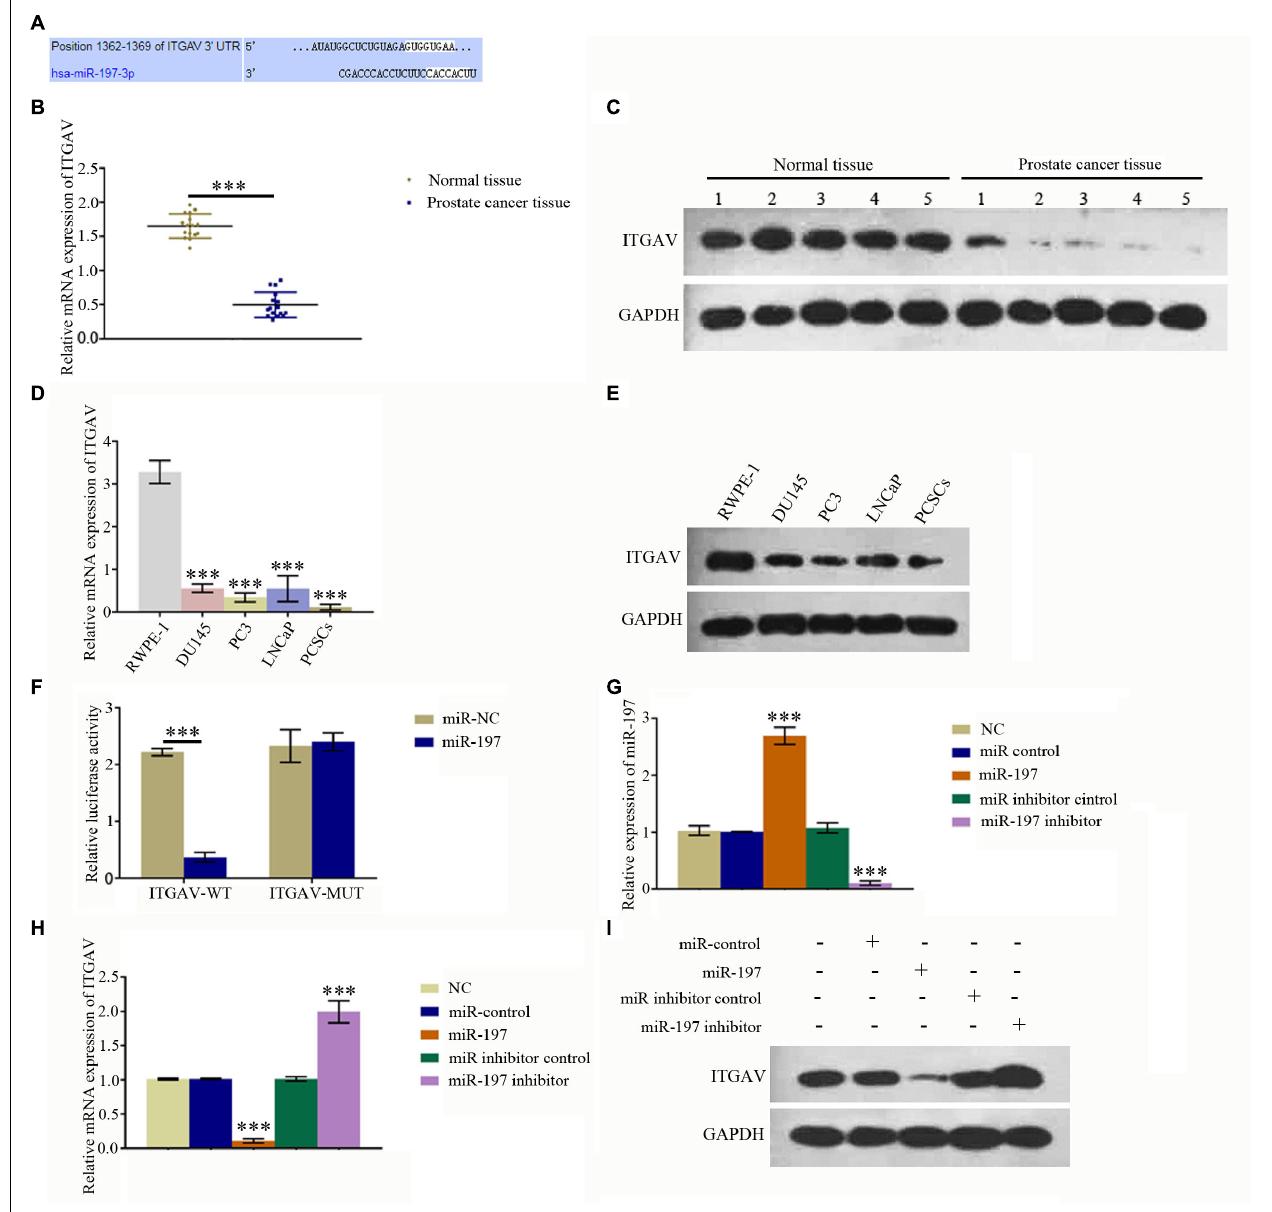
FIGURE 2 | MiR-197 regulated ITGAV expression in prostate cancer tissues and cells. (A) An online bioinformatics analysis was conducted using the TargetScan 7.2 database to determine whether ITGAV could be regulated by miR-197 and 1362–1369 of ITGAV 3 (cid:48) -UTR was found to target miR-197. (B) qRT-PCR assay showed the expression of ITGAV mRNA was lower in prostate cancer tissues. (C) Western blotting assay showed the expression of ITGAV protein was lower in prostate cancer tissues. (D) qRT-PCR assay found the expression of ITGAV mRNA was lowest in prostate cancer stem cells (PCSCs). (E) Western blotting assay determined the protein expression levels of ITGAV was lower in PC3 and PCSCs. (F) Dual luciferase reporter assay confirmed the direct interaction between miR-197 and ITGAV mRNA. (G) qRT-PCR assay determined the expression of miR-197 in PCSCs cells after transfection with the miR control, miR-197 mimic, miR inhibitor control and miR-197 inhibitor. The results showed the expression of miR-197 was lowest in miR-197 inhibitor group. (H) qRT-PCR assay determined the expression of ITGAV mRNA in PCSCs cells after transfection with the miR control, miR-197 mimic, miR inhibitor control and miR-197 inhibitor. The results showed the expression of ITGAV mRNA was highest in miR-197 inhibitor group. (I) Western blotting assays was used to detect the expression of ITGAV, CD133 and the phosphorylation of STAT5 and ERK in PCSCs after transfection with the miR control, miR-197 mimic, miR inhibitor control and miR-197 inhibitor. * p < 0.05, ** p < 0.01, *** p < 0.001.